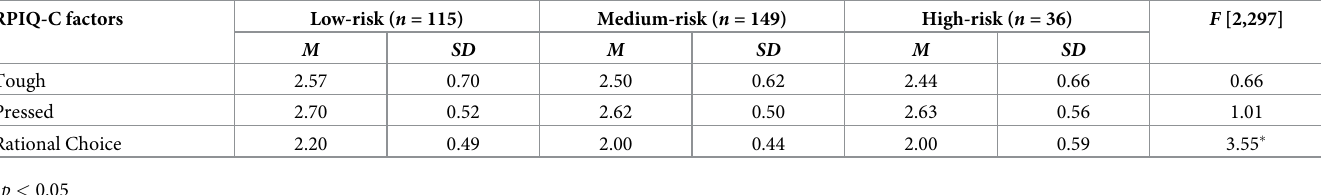
Table 5. Differences in the RPIQ-C factors by risk of injury. RPIQ-C